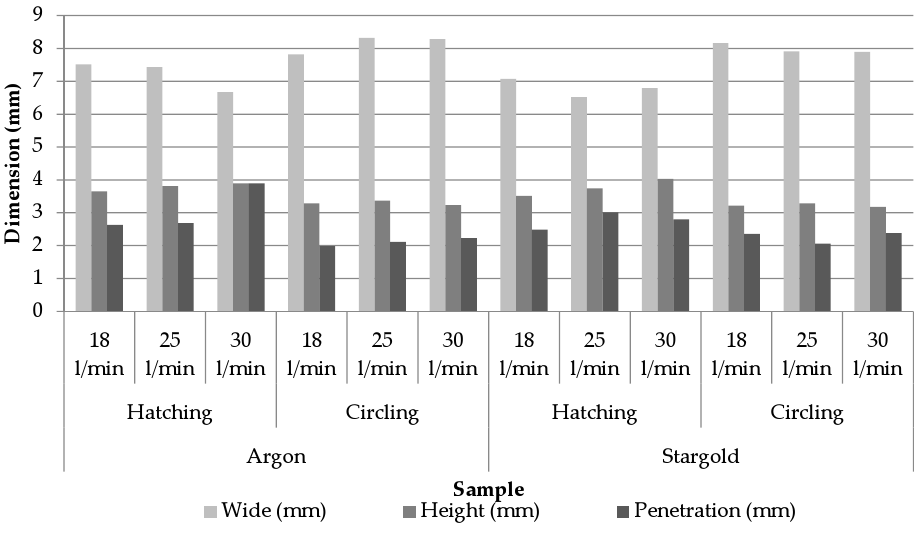
Figure 6. Single weld bead dimensions comparison.